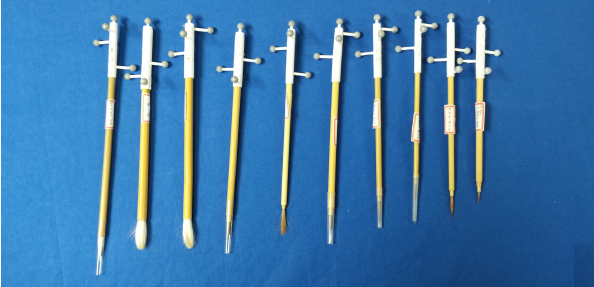
Figure 10. Brushes assembled with marker tools.